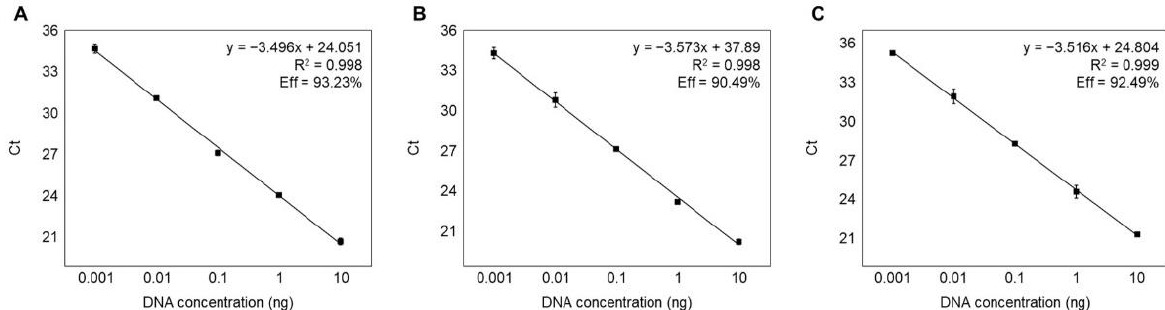
Figure 2. Standard curves by Ct values against DNA concentrations for ( A ) granular ark, ( B ) broughton’s ribbed ark, and ( C ) half-crenate ark. All samples were tested in triplicate. Ultrafast PCR detectability was determined when three positive signals were con- firmed in the PCR reactions, where less than two positive signals were considered negative results (Table 4). The sensitivity of the ultrafast PCR assay for granular ark, broughton’s ribbed ark, and half-crenate ark was 1 pg for each genomic DNA sample (Table 4). The ul- trafast PCR amplicons were confirmed by gel electrophoresis (Figure S2). Previous studies reported detection limits for certain seafood: Kang et al. (2019) developed a